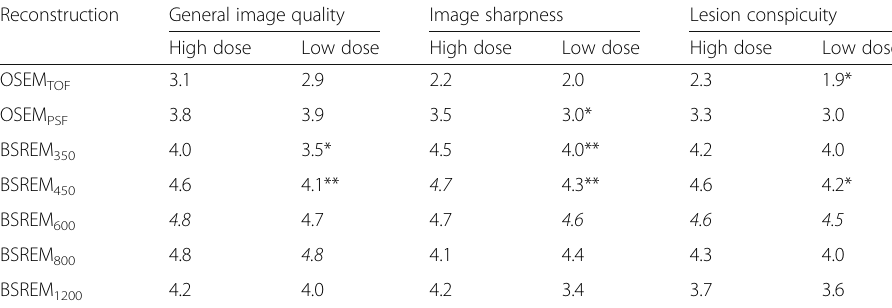
Data are presented as mean BSREM block sequential regularized expectation maximization, OSEM ordered subset expectation maximization, PSF point spread function modelling, TOF time of flight * p value <0.05, ** p value